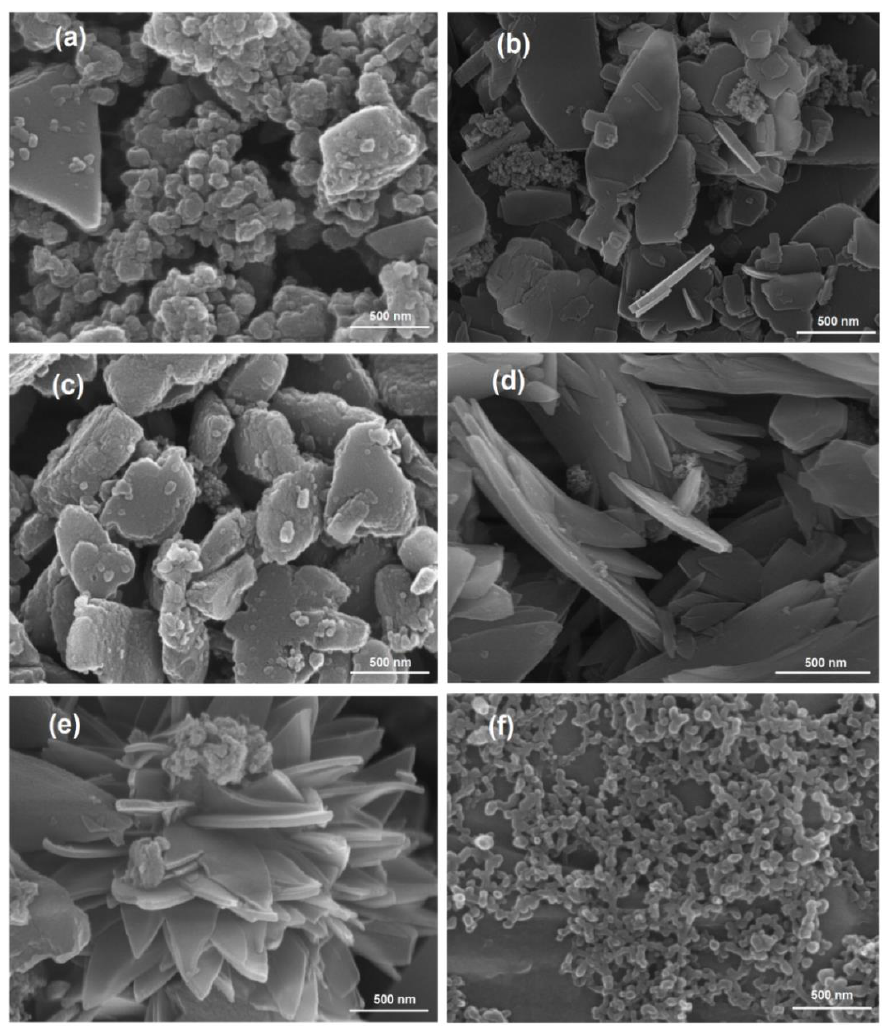
Figure 3. High-resolution FE-SEM (field emission scanning electron microscope) images for the assembly patterns of triads: ( a ) 1 ; ( b ) 2 ; ( c ) 3 ; ( d ) 4 ; ( e ) 5 ; ( f ) 6 .